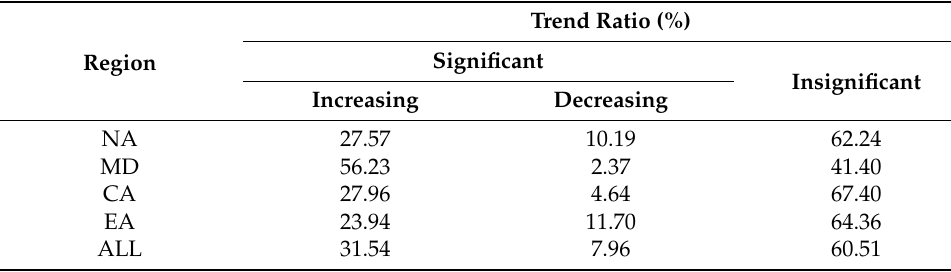
Table 1. Statistical results of the LAI change trend in the four regions.